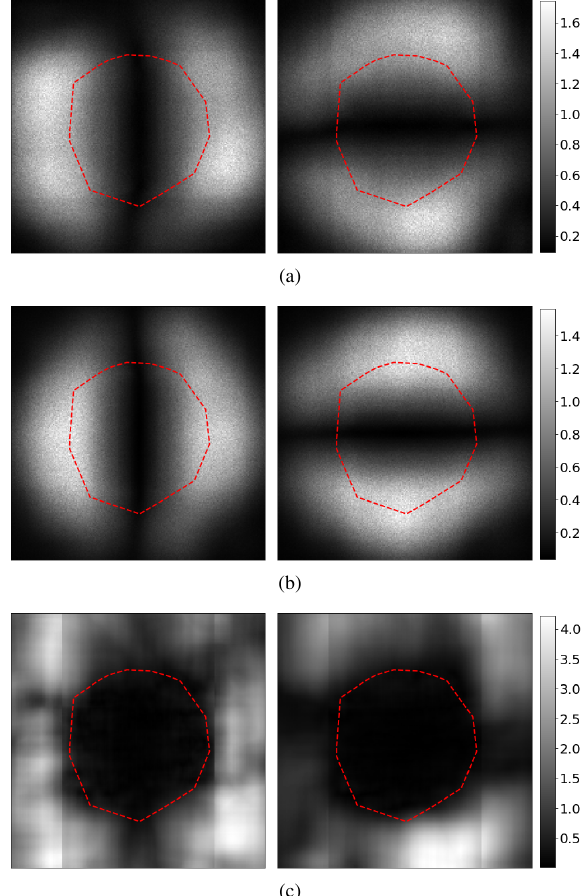
Figure 4. Epistemic standard deviation in column (left) and row (right) direction on the evaluation grid dataset in pixel units with (a) MCDO (Gal and Ghahramani, 2016) , (b) MCDONLL (Kendall and Gal, 2017) and (c) Ensemble (Lakshminarayanan et al., 2017) in case of prior probability shift (case 1) and extrapolation. The red dotted polygon represents the convex hull of the square center positions of the training